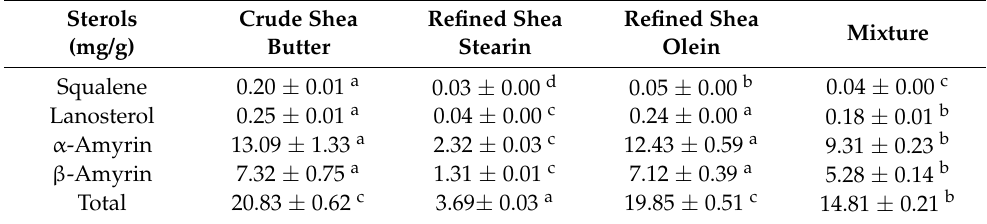
Table 5. Phytosterol content (mg/g) of crude shea butter, refined shea stearin, refined shea olein and a mixture of olein:stearin (1:1 w / w ). Sterols Crude Shea Refined Shea Refined Shea Mixture (mg/g) Butter Stearin Olein Squalene 0.20 ± 0.01 a 0.03 ± 0.00 d 0.05 ± 0.00 b 0.04 ± 0.00 c Lanosterol 0.25 ± 0.01 a 0.04 ± 0.00 c 0.24 ± 0.00 a 0.18 ± 0.01 b α -Amyrin 13.09 ± 1.33 a 2.32 ± 0.03 c 12.43 ± 0.59 a 9.31 ± 0.23 b β -Amyrin 7.32 ± 0.75 a 1.31 ± 0.01 c 7.12 ± 0.39 a 5.28 ± 0.14 b Total 20.83 ± 0.62 c 3.69 ± 0.03 a 19.85 ± 0.51 c 14.81 ± 0.21